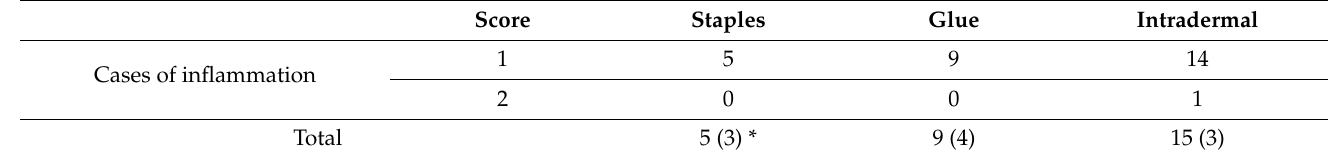
Figure 6. Median (red dot) and interquartile range (column) of scar width (in mm) for each technique (blue: staples, green: glue, gray: intradermal) in each period. [period A: 1–8 po.d.; period B: 9–21 po.d.; period C: 22–63 po.d.; period D: 64–180 po.d.; period E: 181–365 po.d.]. In periods B, C and E, the median scar width with glue was significantly wider from intradermal ( p = 0.001, p = 0.008 and p < 0.001, respectively).